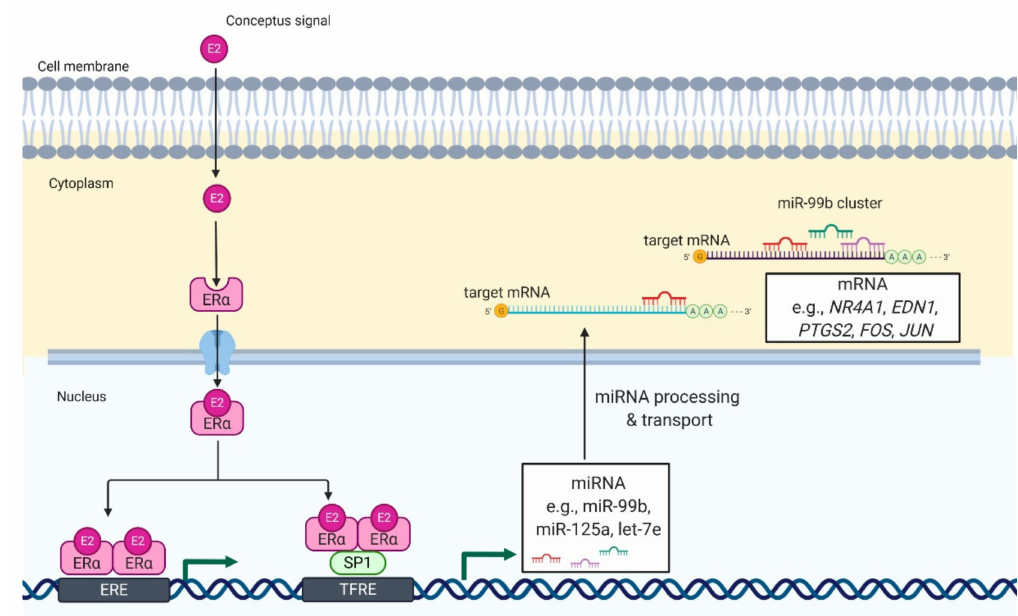
Figure 2. Proposed model of E2-mediated regulation of miRNA expression in luteal tissue during early pregnancy in pigs. E2 enters the luteal cell and binds with its genomic receptor, ER α , located in the cytoplasm. It leads to formation of ER α homodimers and their translocation to the nucleus. In the nucleus, ER α homodimers bind to (1) an estrogen-responsive element (ERE) or (2) transcription factor SP1, which binds to transcriptional factor responsive elements (TFRE) in the promoter region of miR-99b cluster. As a result, there is an increase in the expression of miRNAs belonging to miR-99b cluster (miR-99b, miR-125a, and let-7e), which can target mRNA involved in luteolysis including NR4A1, nuclear receptor subfamily 4 group A member 1; EDN1, endothelin 1; FOS, fos proto-oncogene; JUN, jun proto-oncogene. That mechanisms support the function of luteal cells and allow continuation of progesterone production required for pregnancy establishment and